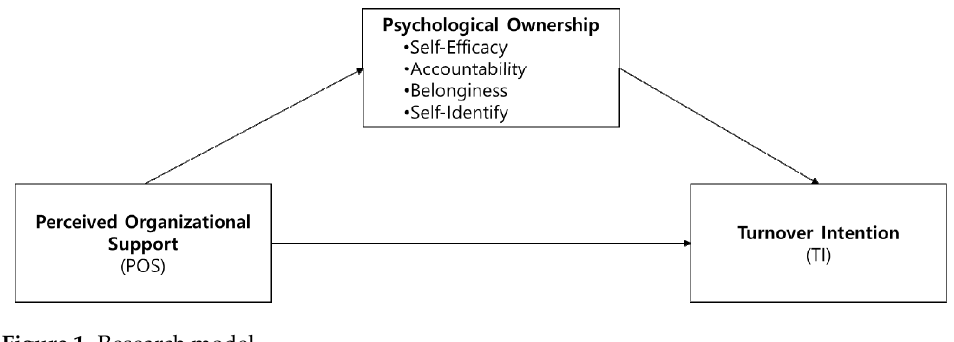
Figure 1. Research model.